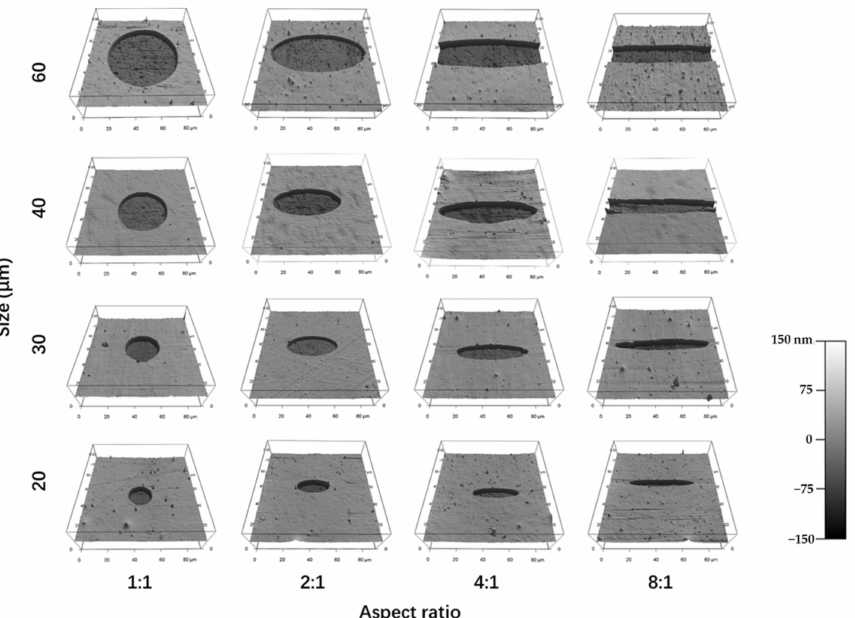
Figure 2. AFM 3D images of the micropatterned surfaces. The round micropatterns had a diameter of 20, 30, 40 and 60 µ m. The elliptic micropatterns had an aspect ratio of 2:1, 4:1 and 8:1. The micropatterns in the same row had the same area, while the micropatterns in the same column had the same aspect